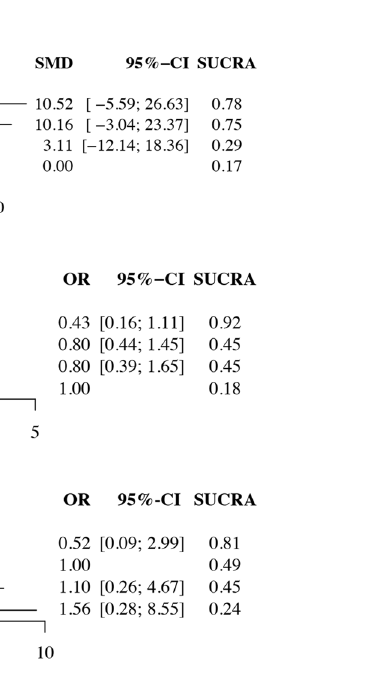
Figure 3. ( A ) Network meta-analysis results of excess weight loss (EWL). SUCRA values among different bougie sizes according to excess weight loss. S- and M-sized bougie had similar effects associated with the greatest EWL improvement among all various bougie sizes. The picture was created with Adobe Photoshop CC 2018 and Sketch Version 45.1 software. ( B ) Network meta-analysis results of total complications. SUCRA values among different bougie sizes according to total complications. M-sized bougie was associated with the lowest incidence of total complications. The picture was created with Adobe Photoshop CC 2018 and Sketch Version 45.1 software. ( C ) Network meta-analysis results of the staple line leak (SLL). SUCRA values among different bougie sizes according to total complications. M-sized bougie was associated with the lowest incidence of SLL. The picture was created with Adobe Photoshop CC 2018 and Sketch Version 45.1